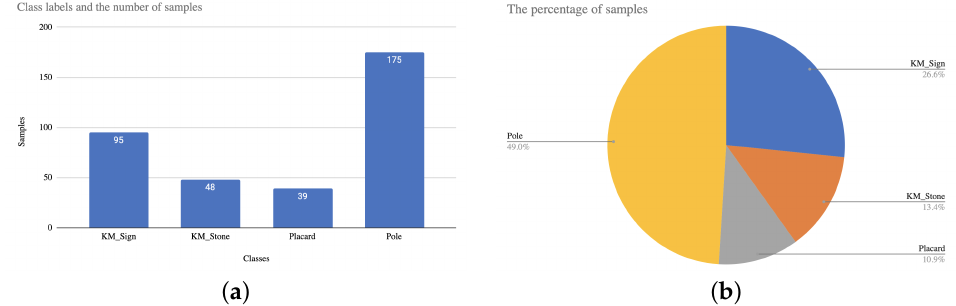
Figure 3. The sample size of annotated class and its corresponding object class in the Road Asset corpus. Sample size for each class ( a ) and Percent of sample size for each class ( b